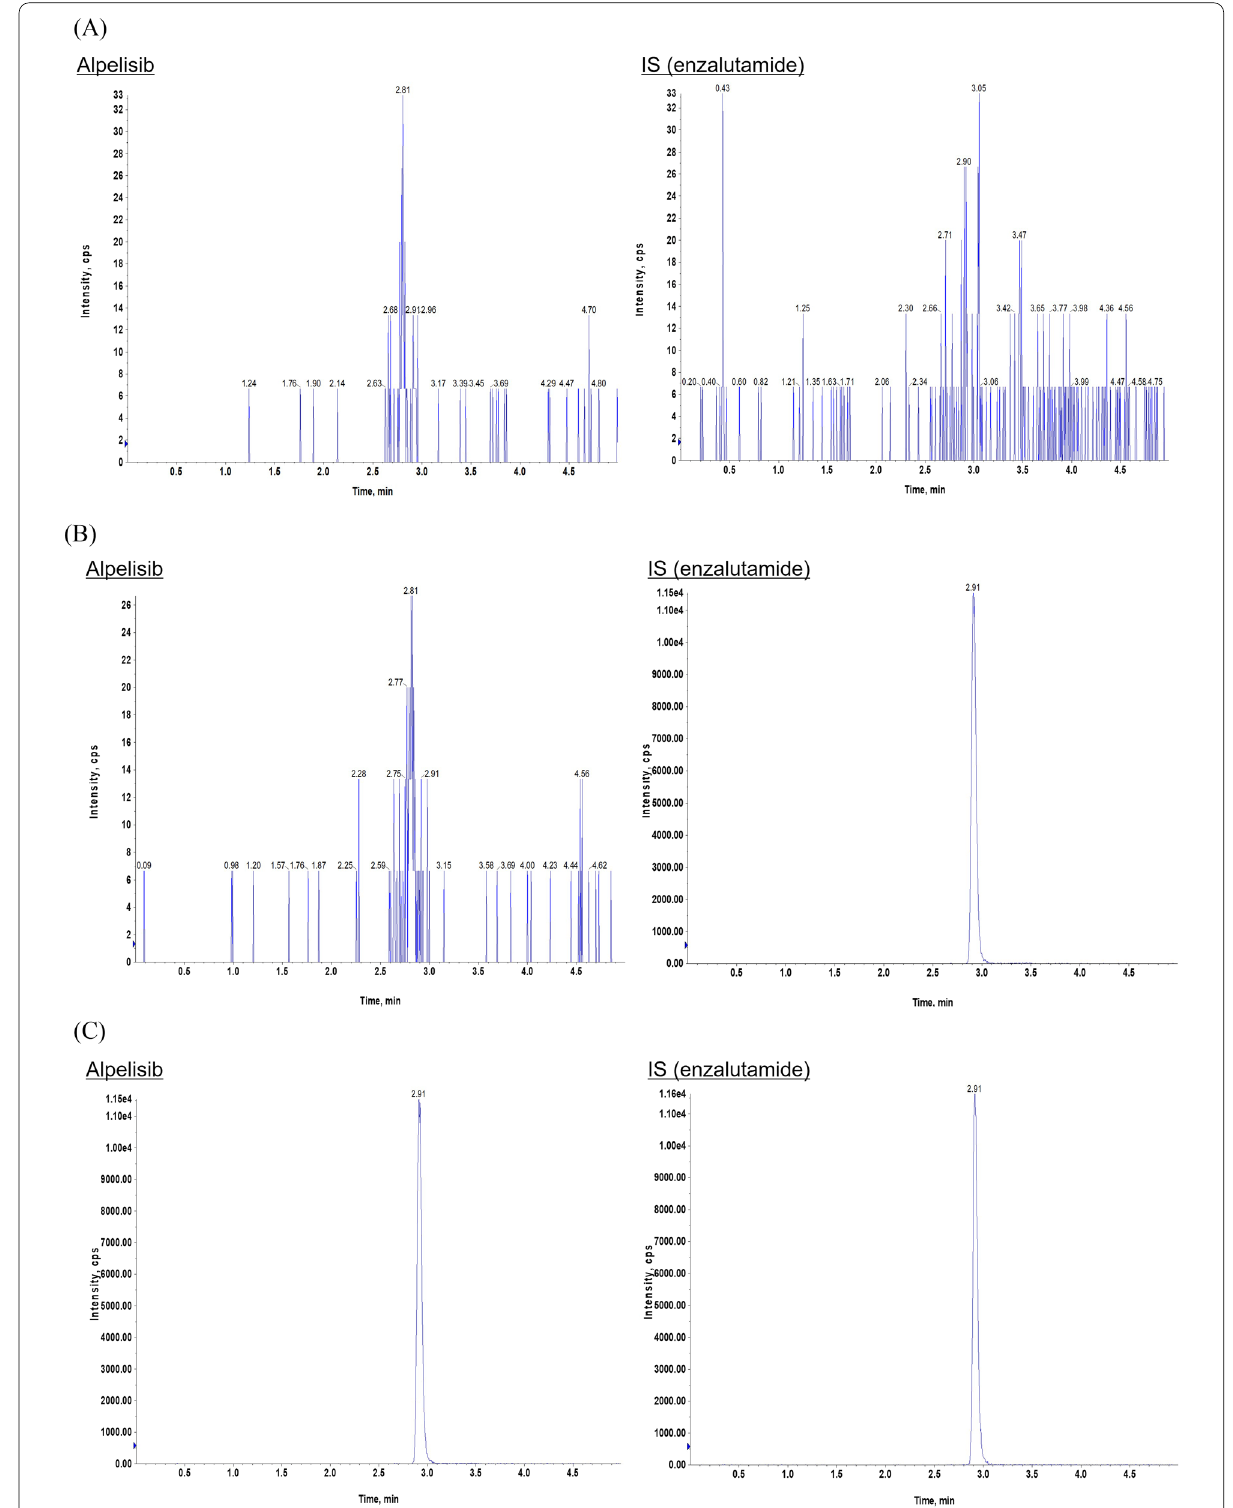
Fig. 2 Typical multiple reaction monitoring chromatograms of alpelisib and the internal standard (IS; enzalutamide). a Blank mouse plasma; b blank mouse plasma spiked with the IS (300 ng/mL); c lowest limit of quantification (LLOQ; 1 ng/mL) sample in mouse plasma; d mouse plasma sample collected at 1 h after oral administration of alpelisib at a dose of 50 mg/kg in mice; e blank human plasma; f blank human plasma spiked with the IS (300 ng/mL); and g LLOQ (1 ng/mL) sample in human